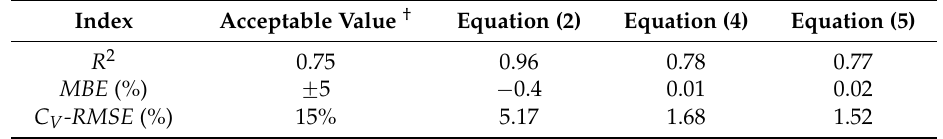
Table 1. Statistical indices of the baseline